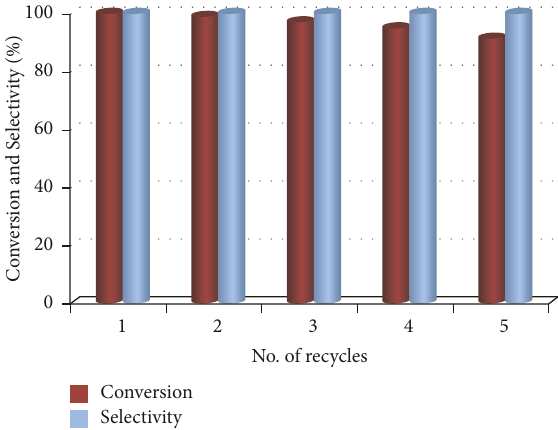
Figure 10: The reusability of 1% ZrO –MnCO 3 catalyst in the x oxidation of 1-phenylethanol. (Reaction conditions: 2 mmol of 1- phenylethanol, calcination temperature at 300 ∘ C, oxygen with rate 20 mLmin −1 , 0.5 g of catalyst, reaction temperature at 100 ∘ C, 10mL of toluene, and 6 min of reaction